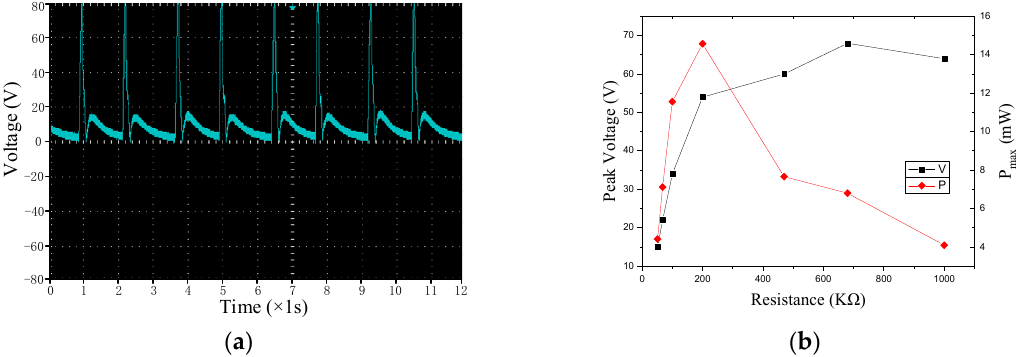
Figure 14. Output after full bridge rectifier circuit. ( a ) voltage waveform; and ( b ) peak voltage and power.